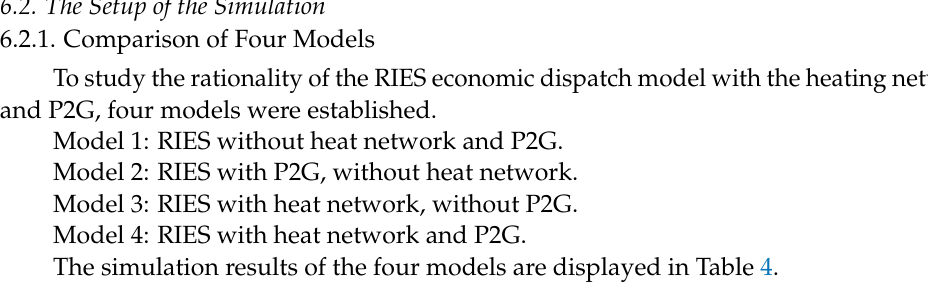
Figure 3. Time-of-use electricity price in the industrial area.